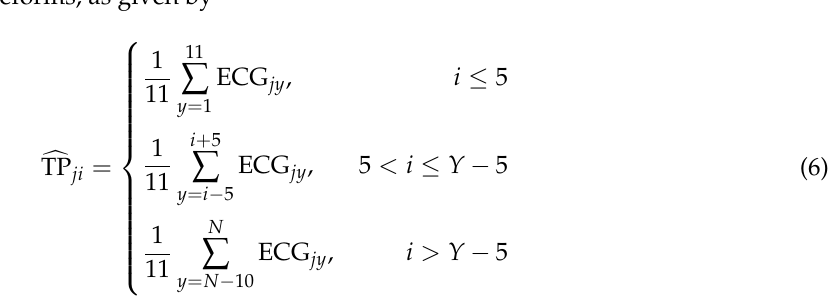
Figure 3a. The approximation coefficient at each decomposition level, cA z ( z = 1, 2, ..., Z ), was obtained by convolving the approximation coefficient of the previous level, cA z − 1 ( cA 0 = x j ), with a low-pass were obtained by convolving cA z − 1 with a high-pass decomposition filter Hi D followed by the downsampling, as shown in Figure 3b. The high-pass and low-pass decomposition filters were derived from a mother wavelet function and designed to form quadrature mirror filters. The db 4